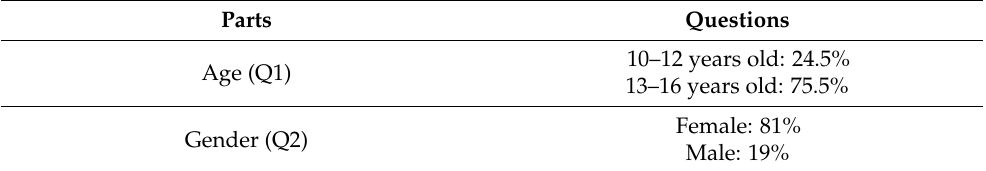
Table 2. Brief characterization of the sample.